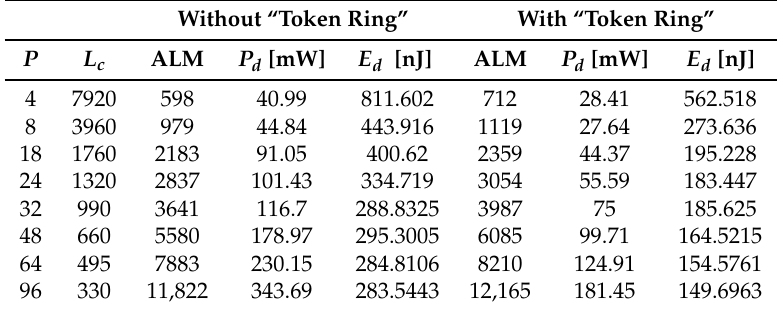
Table 5. Analysis of the impact of P on energy consumption and hardware demand ( f = 400 MHz).